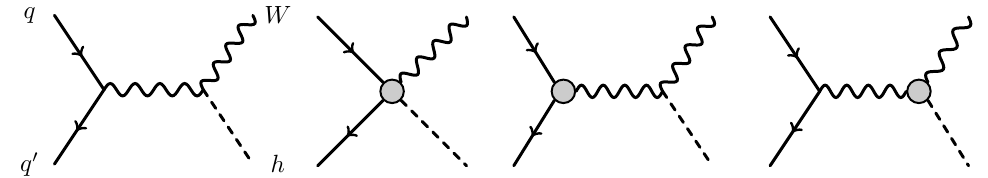
Figure 1 . Representative Feynman diagrams for q q diagram shows the SM process while the gray circles in the other diagrams represent one insertion of a dimension-6